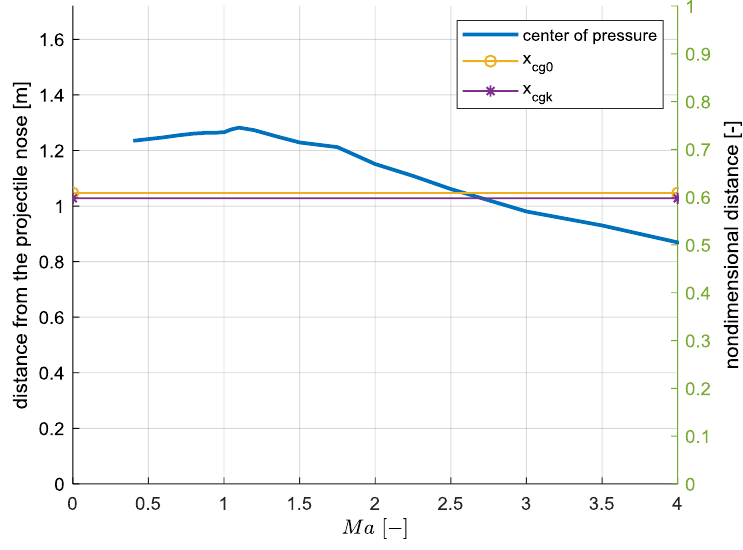
Figure 6. Projectile center of pressure location.